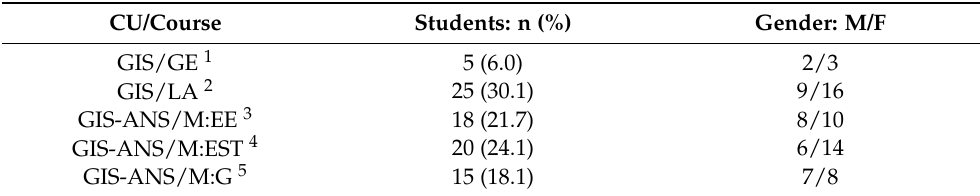
Table 1. Distribution of the students in the different curricular units (CUs) and courses. GIS: Geographic Information Systems; GIS-ANS: GIS Applied to Natural Sciences.